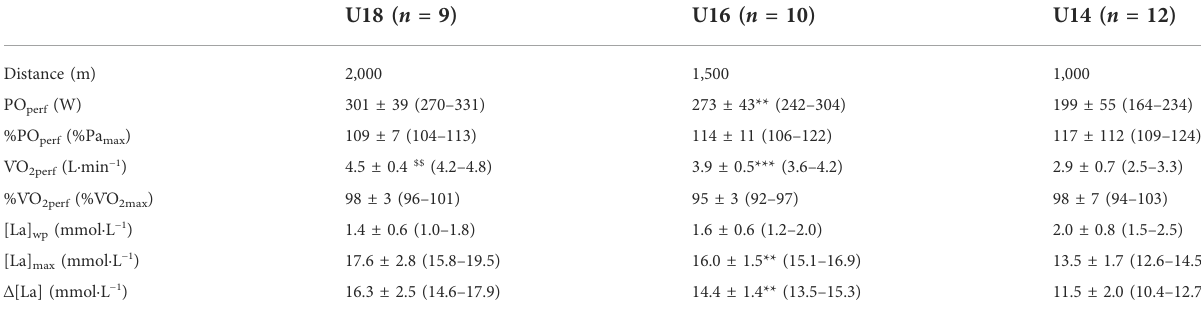
TABLE 2 Performance and physiological characteristics obtained during the rowing ergometer test over 2,000 m for rowers under 18 years (U18), 1,500 m for rowers under 16 years (U16) and 1,000 m for rowers under 14 years